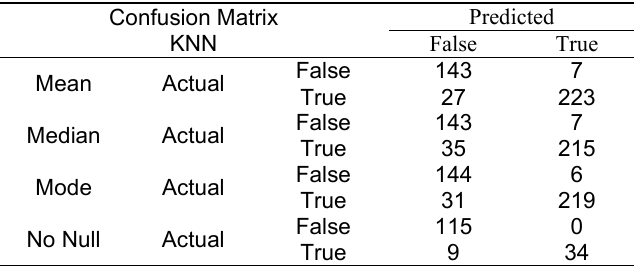
Table 2. Confusion Matrix for K-Nearest Neighbour